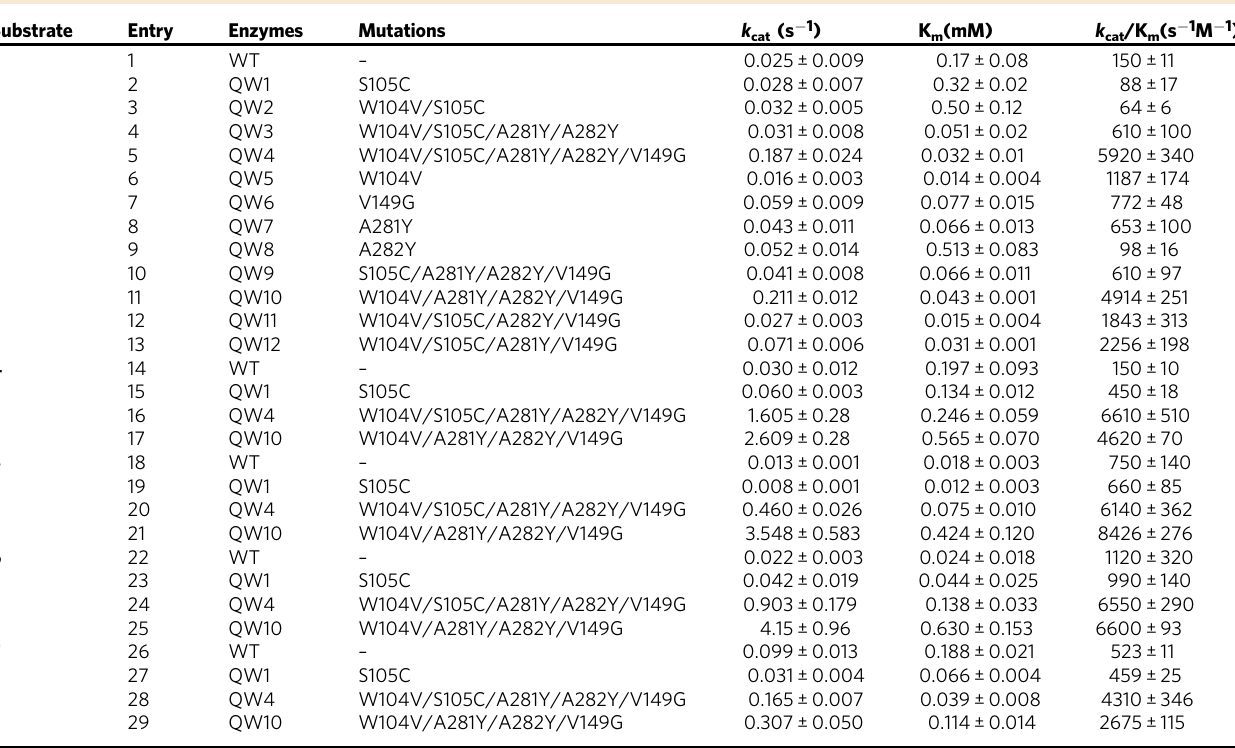
Table 1 Kinetic data of WT CALB and mutants